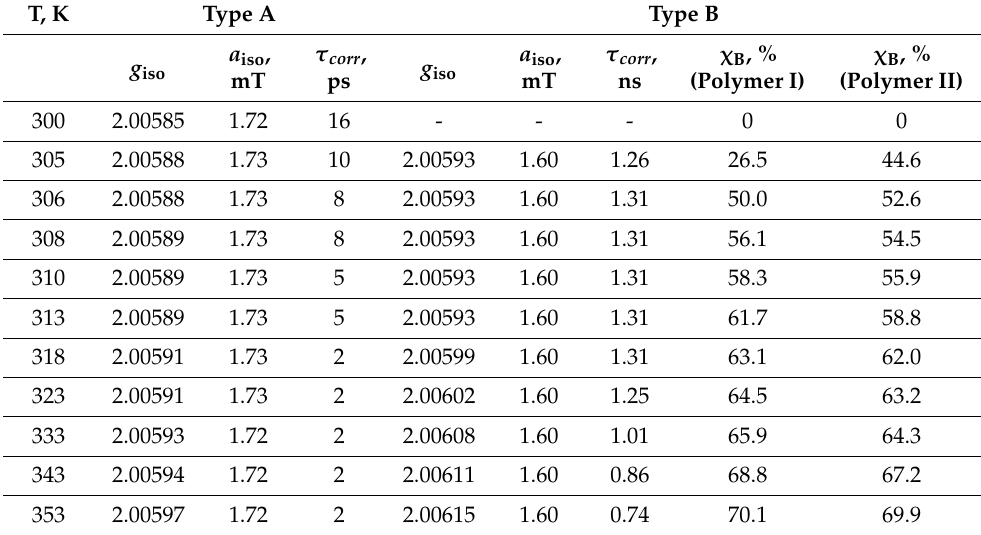
Table A1. Selected spectral parameters from simulation TEMPO EPR spectra in 10 wt%